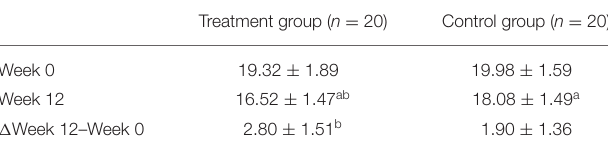
TABLE 4 | Change in ADAS–cog values within and between groups (mean ±